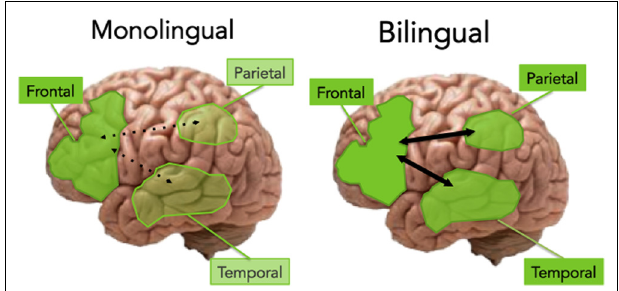
FIGURE 2 |An illustration of the monolingual vs. bilingual aging brain . In monolinguals, aging is associated with an increased reliance on the frontal regions, according to the PASA hypothesis. In bilinguals, the aging brain shows preservation of the posterior regions (including temporal and parietal cortex), as well as increased connectivity between frontal and posterior areas, leading to cognitive reserve.